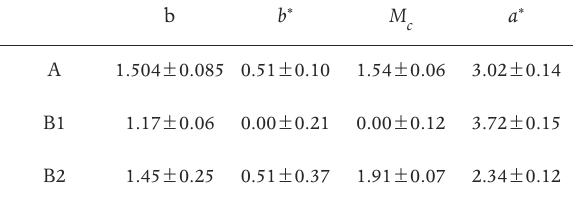
Figure 5. Time series for the BKE catalogue. The meaning of the symbols is the same as for Figure 3. The superimposed black his- togram represents the number of events having M ≥ 0.5, which is in the bottom panel. The arrow indicates the maximum value of M c the step in the cumulative strain release related to the October 9, 1999, (M=3.6)